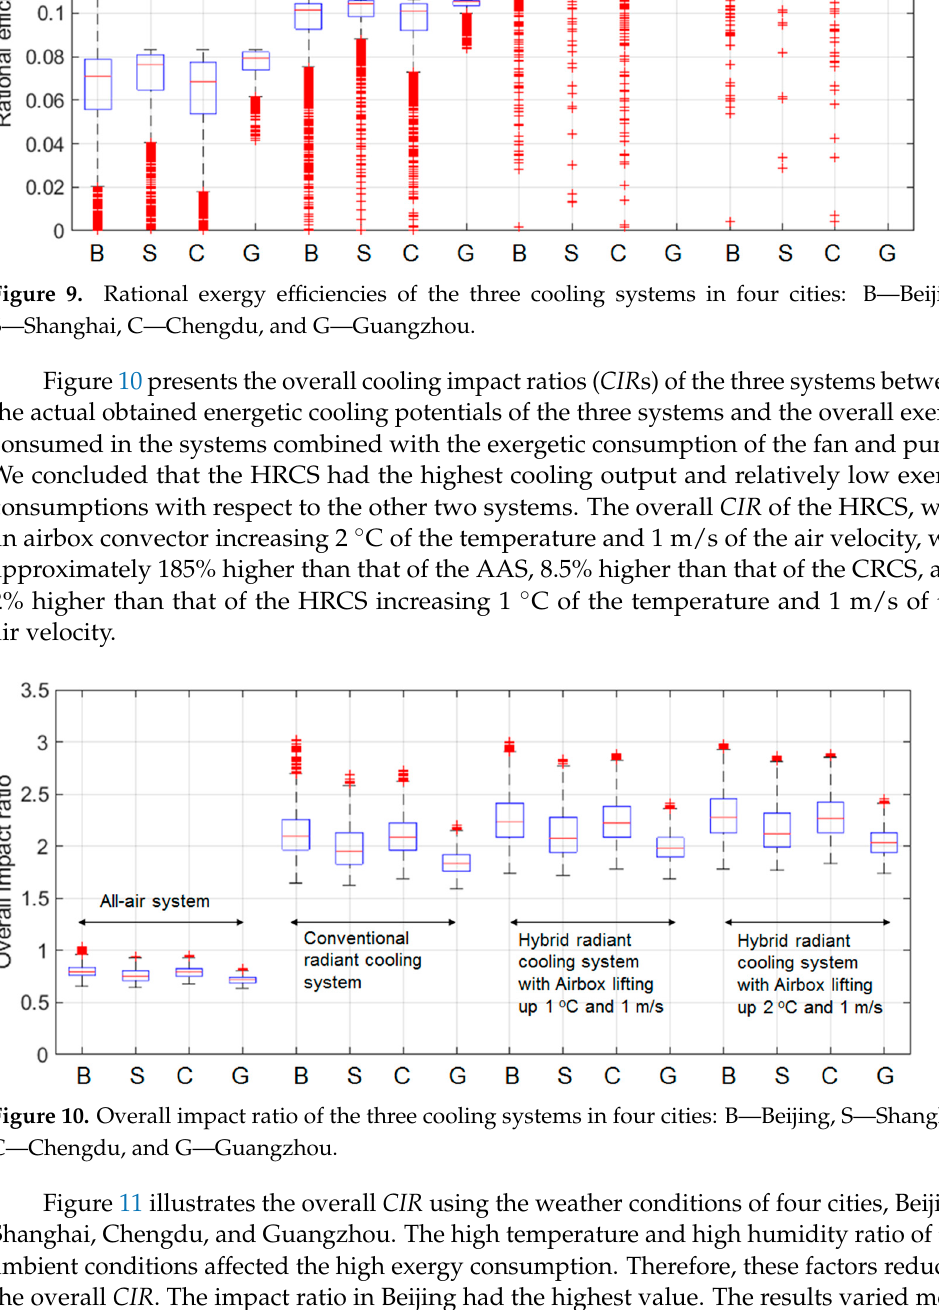
13 of 21 Figure 8. Simple exergy efficiencies of the three cooling systems in four cities: B—Beijing, S—Shang- hai, C—Chengdu, and G—Guangzhou.